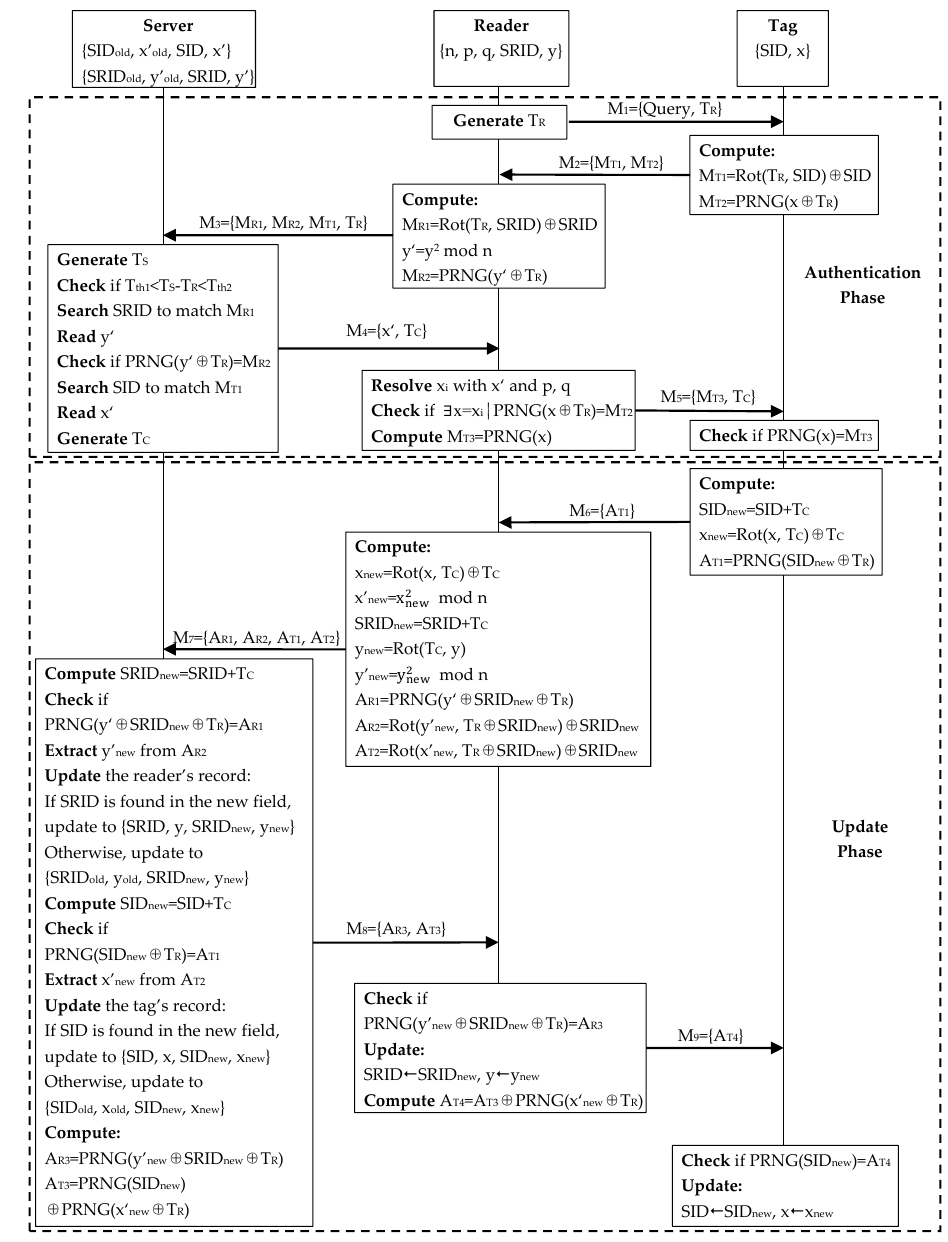
Figure 4. Authentication and update phases of Fan et al.’s scheme.